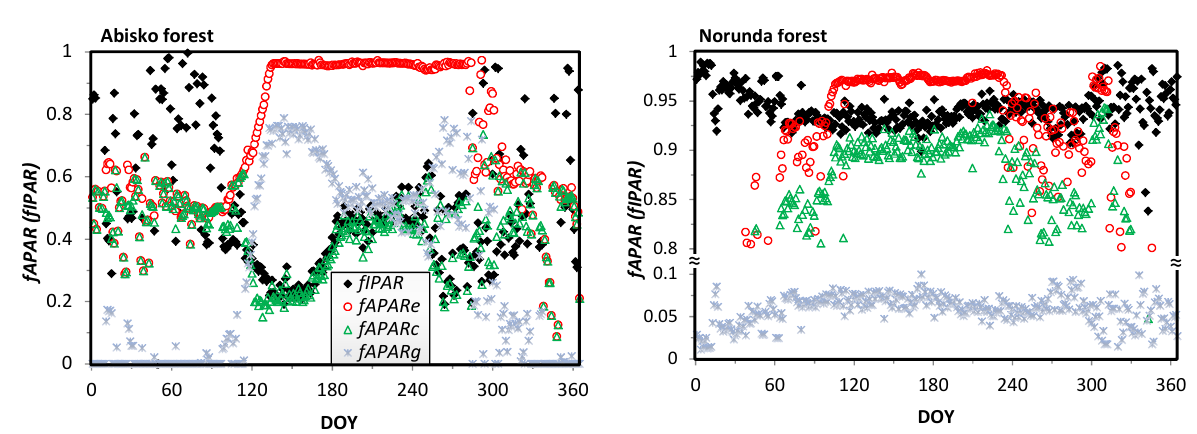
Figure 10. fIPAR and fAPAR at the Abisko (left) and Norunda (right)